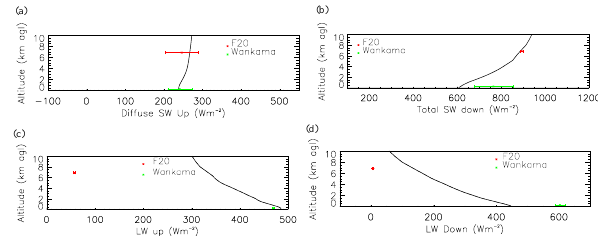
Fig.8. ComparisonbetweenirradiancesprofilesderivedfromSTREAMER(blacksolidline)obtainedatthelocationoftheWankamastation andatthetimeoftheF/F20overpasson14June.ThedatafromtheF/F20areinredanddatafromtheWankamastationareingreen:upward shortwave (a) downwardshortwave (b) ,upwardlongwave (c) anddownwardlongwave (d) . Fig. 8. Comparison between irradiances profiles derived from STREAMER (black solid line) obtained at the location of the Wankama station and at the time of the F/F20 overpass on 14 June. The data from the F/F20 are in red and data from the Wankama sta- tion are in green: upward shortwave (a) downward shortwave (b) , upward longwave (c) and downward longwave (d)